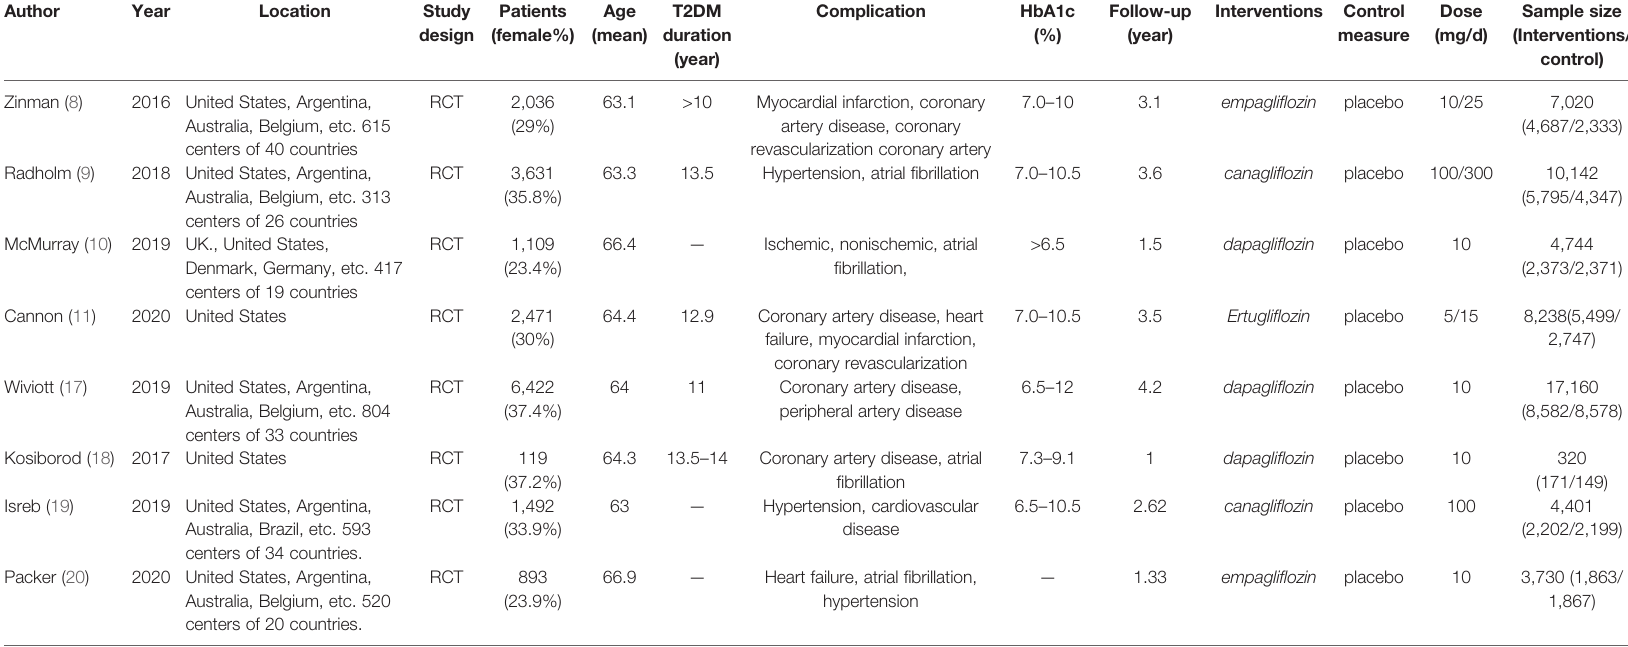
TABLE 1 | Demographic and clinical characteristics of studies included in the